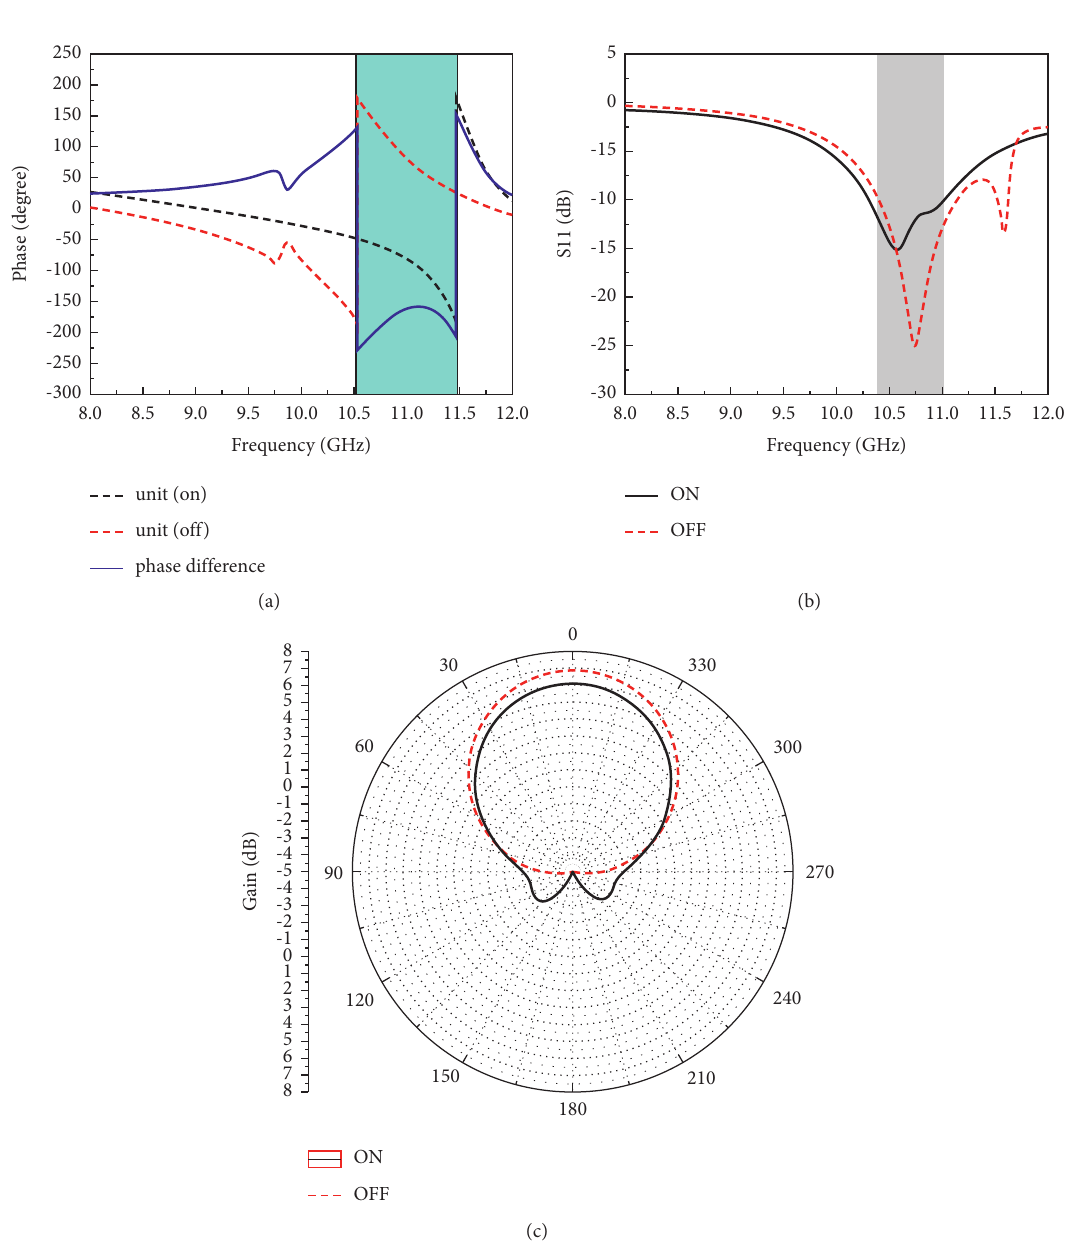
Figure 4: Simulated results of proposed antenna unit; (a) phase information of “ON” and “OFF” states; (b) amplitude of reflection of two states; (c) simulated gain of two